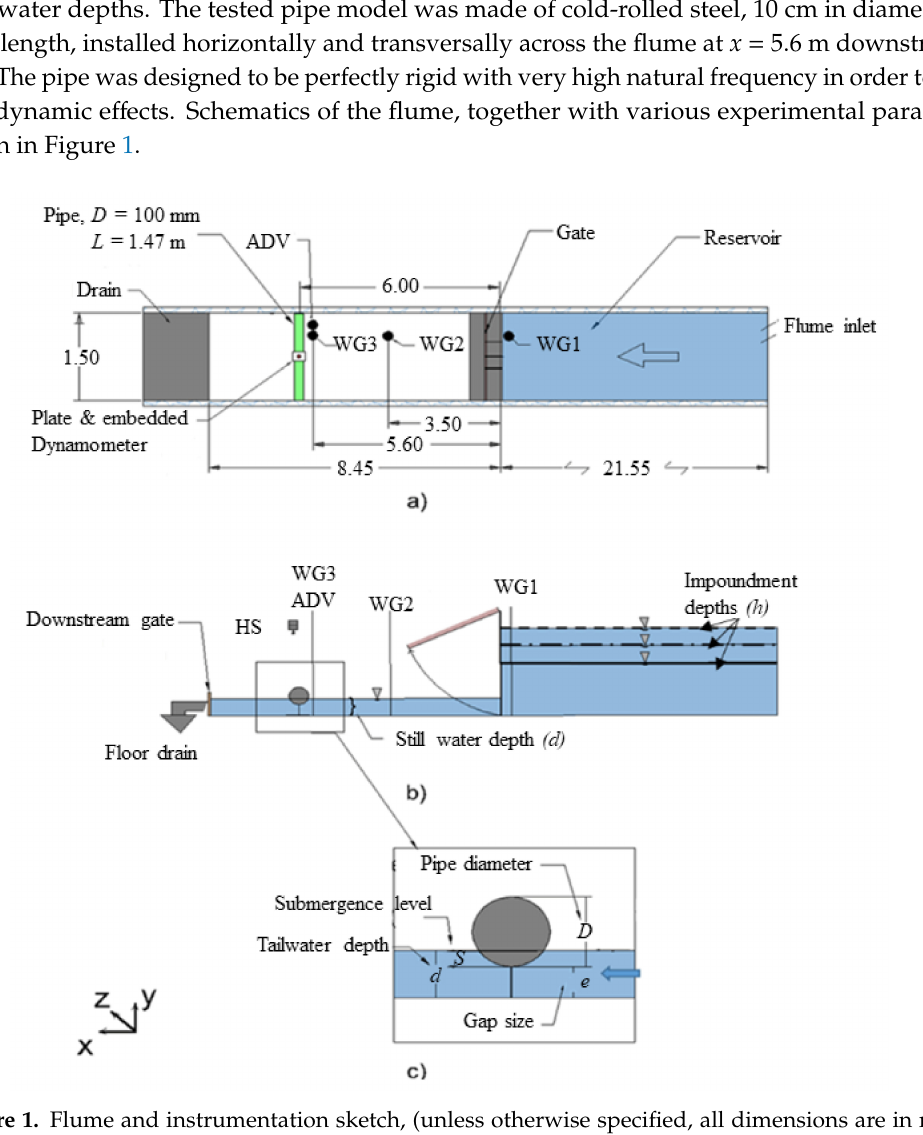
Figure 1. Flume and instrumentation sketch, (unless otherwise specified, all dimensions are in m). ( a ) Plan view, ( b ) side view and ( c ) close view with pipe and experimental